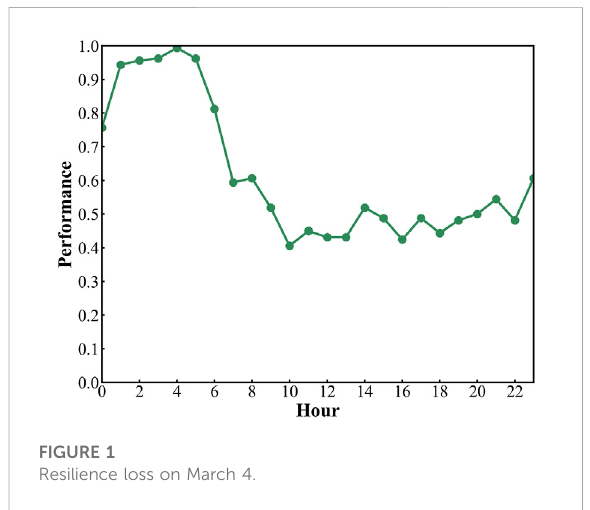
FIGURE 1 Resilience loss on March 4.